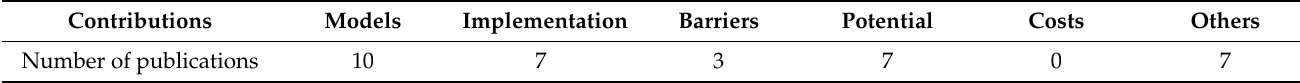
Table 4. Trend of research on demand response in Asia.